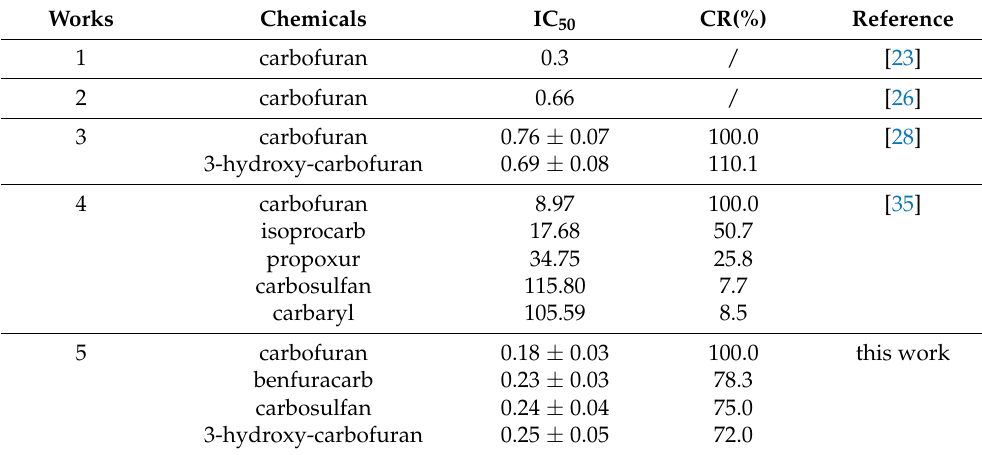
Table 4. Performance comparison of ic-ELISA.